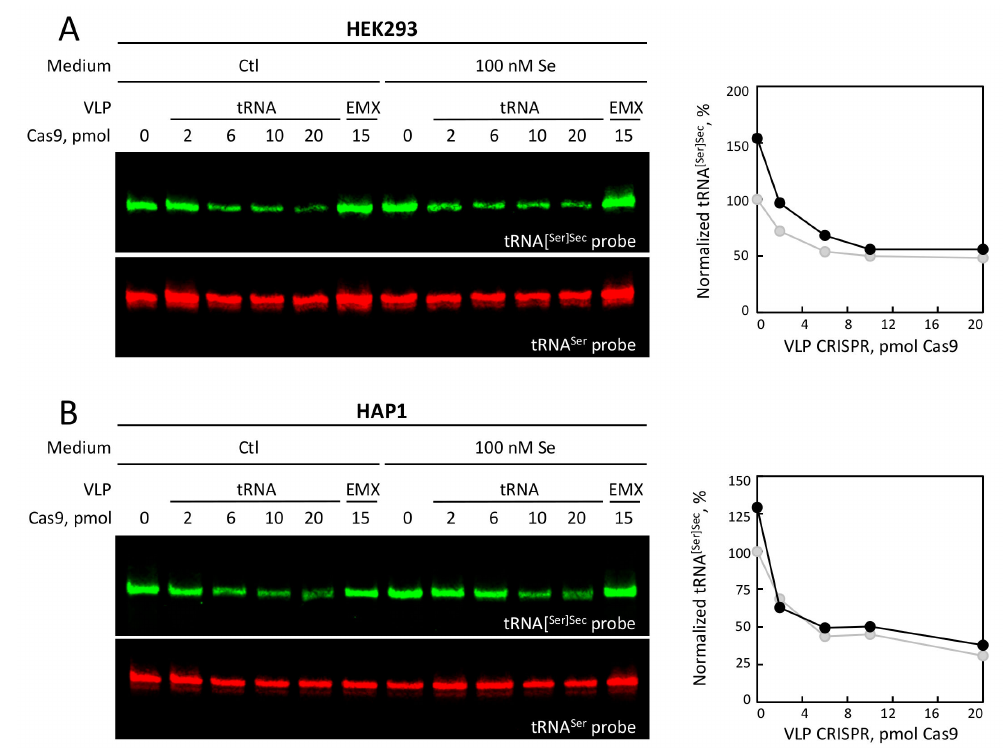
Figure 6. Evolution of tRNA [Ser]Sec expression levels in response to the CRISPR-Cas9-VLP treatments and / or addition of selenium (100 nM) in Hek293 ( A ) and HAP1 ( B ) cell lines. Cells were treated with increasing amounts of CRISPR-Cas9-VLPs, targeting either tRNA [Ser]Sec or EMX gene. Four days after transduction, cells were grown for another four days with or without 100 nM Se in the culture medium. Total RNAs were extracted and 15 µ g were analyzed by northern blot using tRNA [Ser]Sec (green) and tRNA Ser (red) DNA probes for hybridization. The levels of tRNA [Ser]Sec were normalized over the ones of tRNA Ser and expressed relative to the first lane, which was set to 100%. In the right panels, the decrease of tRNA [Ser]Sec levels was plotted as a function of Cas9 amount in control conditions (Ctl, grey circles) or with a 100 nM Se concentration in the medium (black